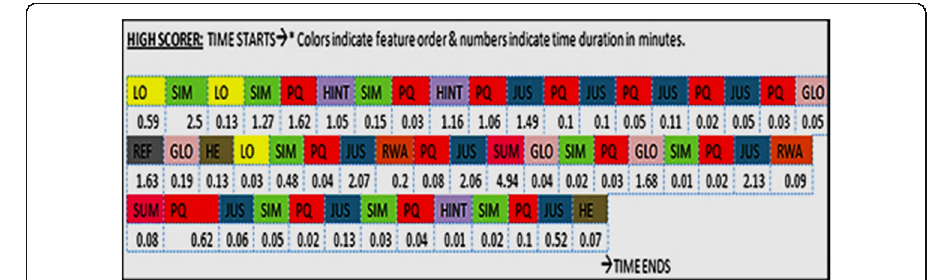
Fig. 10 Learning path of a high scorer as she progresses in MIC-O-MAP